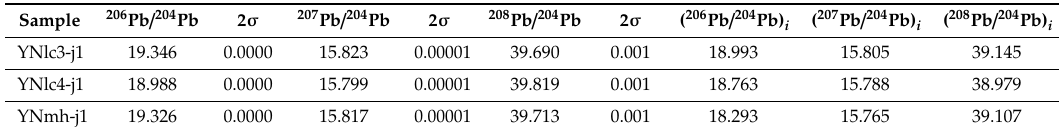
Table 5. Pb isotope ratios of the QN and MH